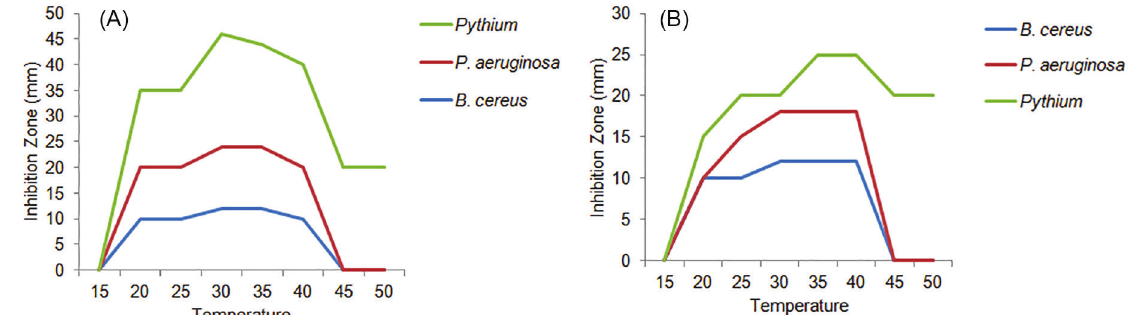
FIGURE 7 - The effect of temperature on the antimicrobial activity of B. amyloliquefaciens DSM7 and B. subtilis subsp.